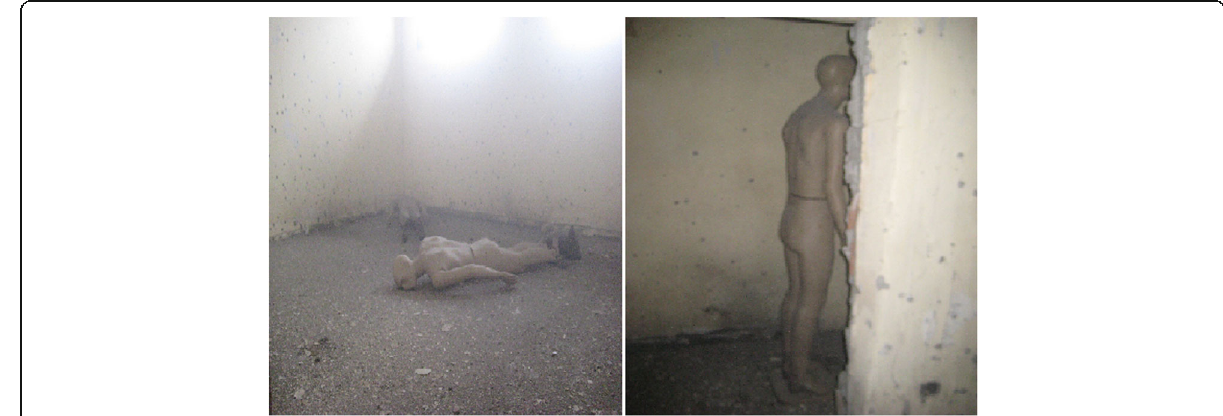
Fig. 13 The test room after detonation On the Mannequin-2 (male-2) lied face down on left opposite corner of the room due to the door (Fig. 14).